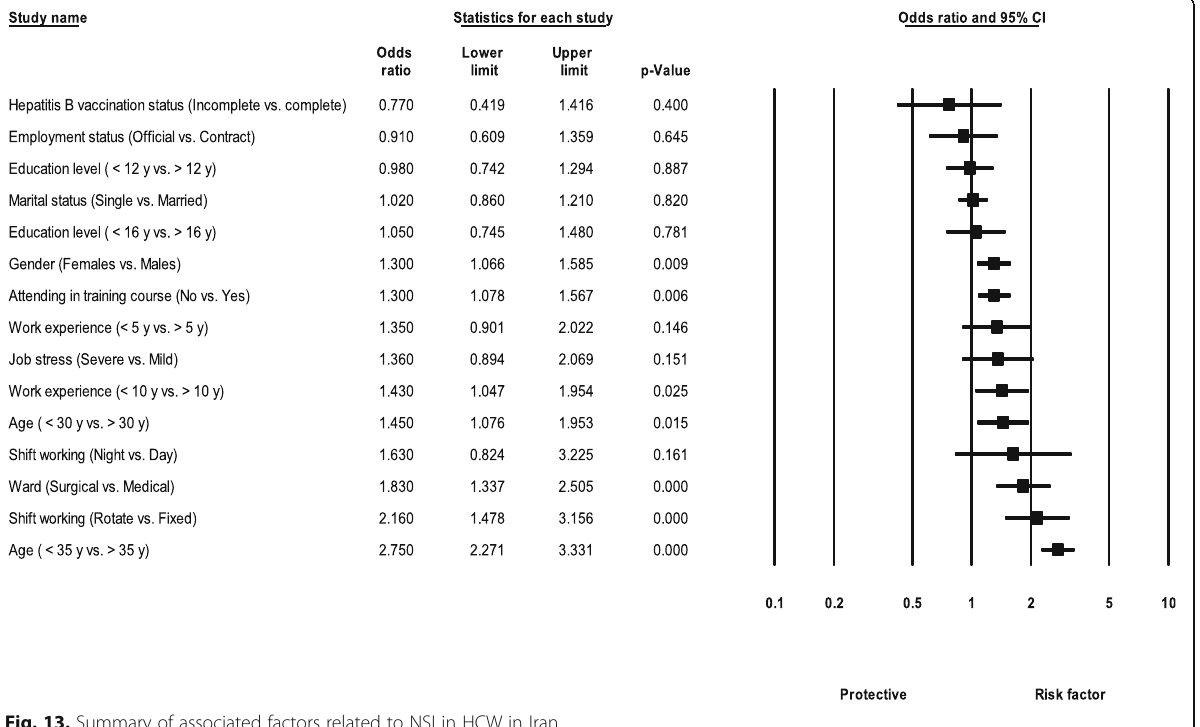
Fig. 13. Summary of associated factors related to NSI in HCW in